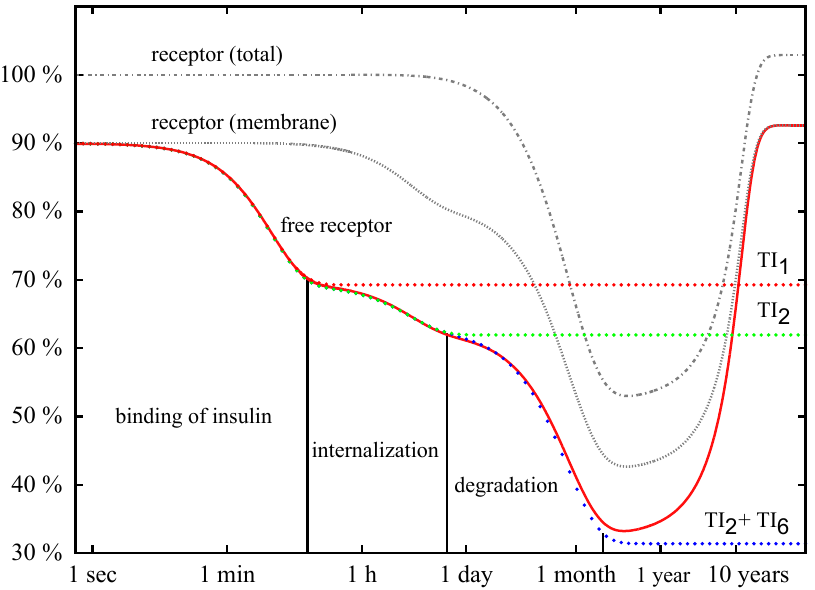
Figure 9. Precise numerical solutions for the concentration of accessible IR on the membrane (solid line with the label free receptor ), the total concentration of IR on the = ir + iri + irip (solid line with the label receptor (membrane) ), membrane, ir memb = ir + irip + ir and the total concentration of the IR, ir (solid line with the tot memb in in label receptor (total) ), are plotted versus the logarithmic time axis. The concentrations are given in percentage of the total concentration, ir , of the IR of the basal cell. The initial tot = 1 nM. The down-regulation of the cell for insulin given in insulin concentration is i 0 excess passes through three phases: binding of insulin, internalization of the activated IR, and degradation of the IR inside the cell. The analytical approximation (Equation 6) for the concentration of the IR is drawn as dotted line with the label TI and describes the fast 1 binding of insulin to the IR. The dotted line with the label TI shows the approximation (8). 2 The analytical solution (Equation 11) for the concentration of the IR is depicted as dotted line with the label, TI + TI , and is indistinguishable from the precise numerical solution 2 6 (solid line free receptor ) until the QSSA breaks down, i.e. , until the consumption of insulin becomes measurable. The concentration of insulin is not